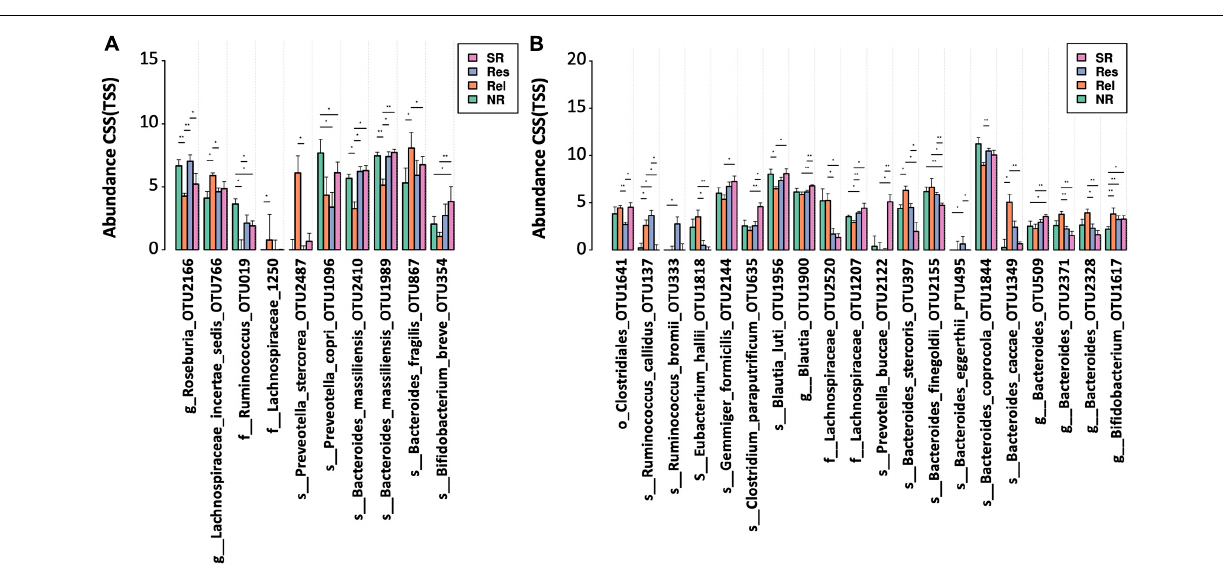
FIGURE 5 | Bacterial taxa associated with different FMT outcomes. OTUs were compared among the patient with different therapeutic outcomes (A) before and (B) after FMT. Significance was determined by Kruskal-Wallis test ( p < 0.05) and confirmed by pairwise Mann-Whitney U test (* p < 0.05 and ** p < 0.01) NR, no response; Rel, relapse; Res, responders; SR, sustained